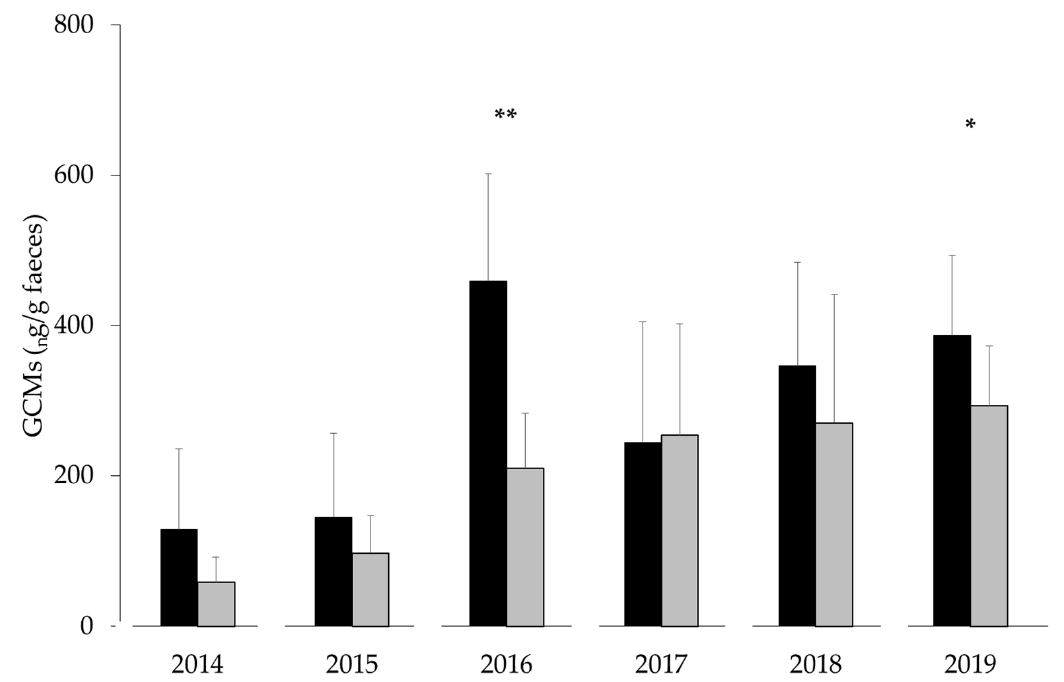
Figure 2. Fluctuations in the GCM concentrations (mean ± SD) of female mountain hares during the early breeding period (black) and the post-breeding period (grey) in the Swiss National Park from 2014 to 2019 (* p < 0.05 and ** p <